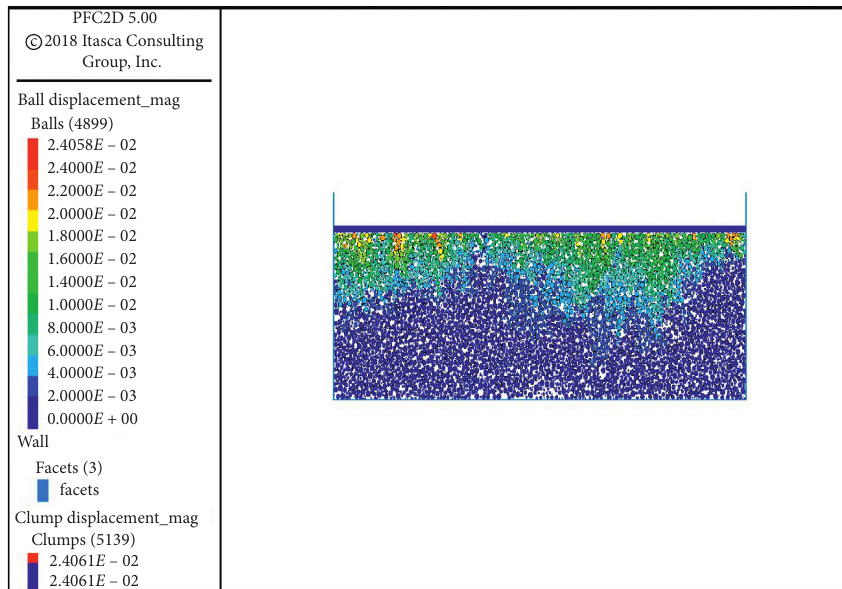
Figure 15: Discrete element particle migration map of 50cm thick reclaimed soil with one